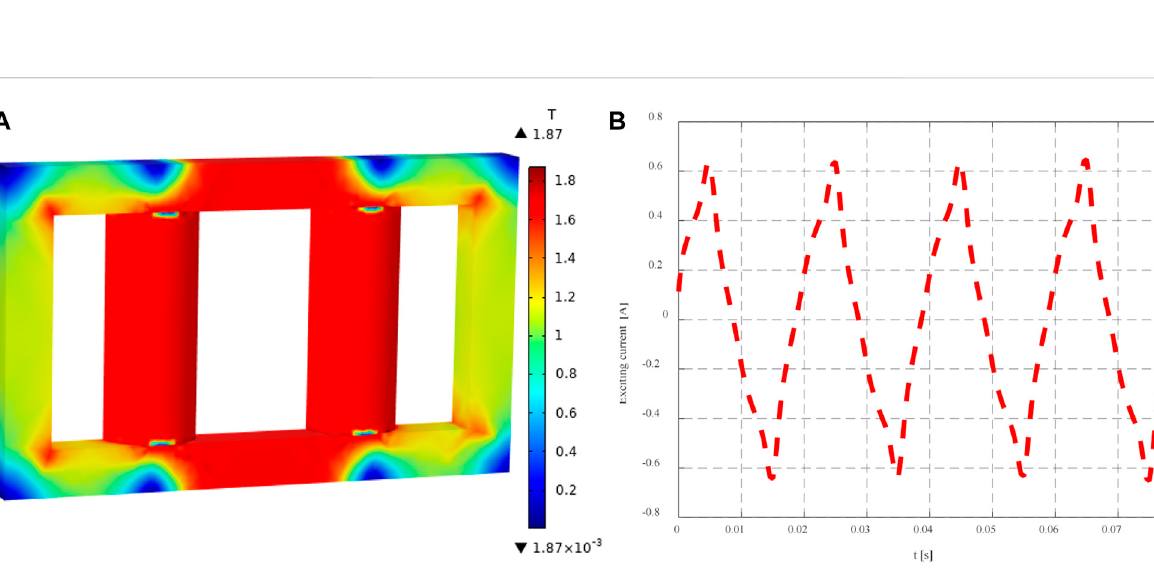
FIGURE 11 Magnetic density distribution and excitation current waveform of converter transformer under the no-load condition: (A) Magnetic density distribution of converter transformer; (B) Excitation current